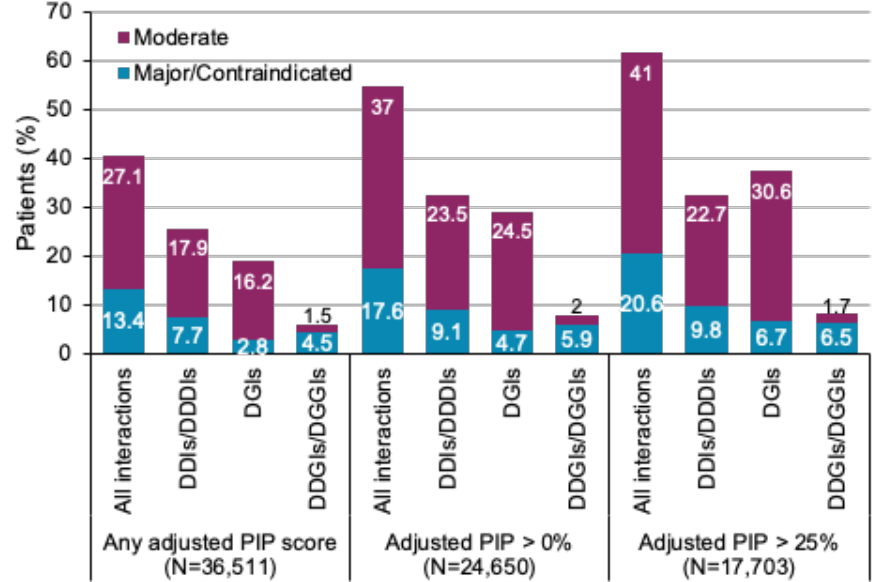
Figure 3. Comparative data on type and severity of interactions. If a patient had multiple identified interactions, only the interaction with the highest severity rating was considered in the frequency analysis per section. Abbreviations: drug – drug – drug interaction, DDDI; drug – drug interaction, DDI; drug – gene interaction, DGI; drug – drug – gene interaction, DDGI; drug – gene – gene interaction, DGGI; pharmacogenetic interaction probability, PIP.